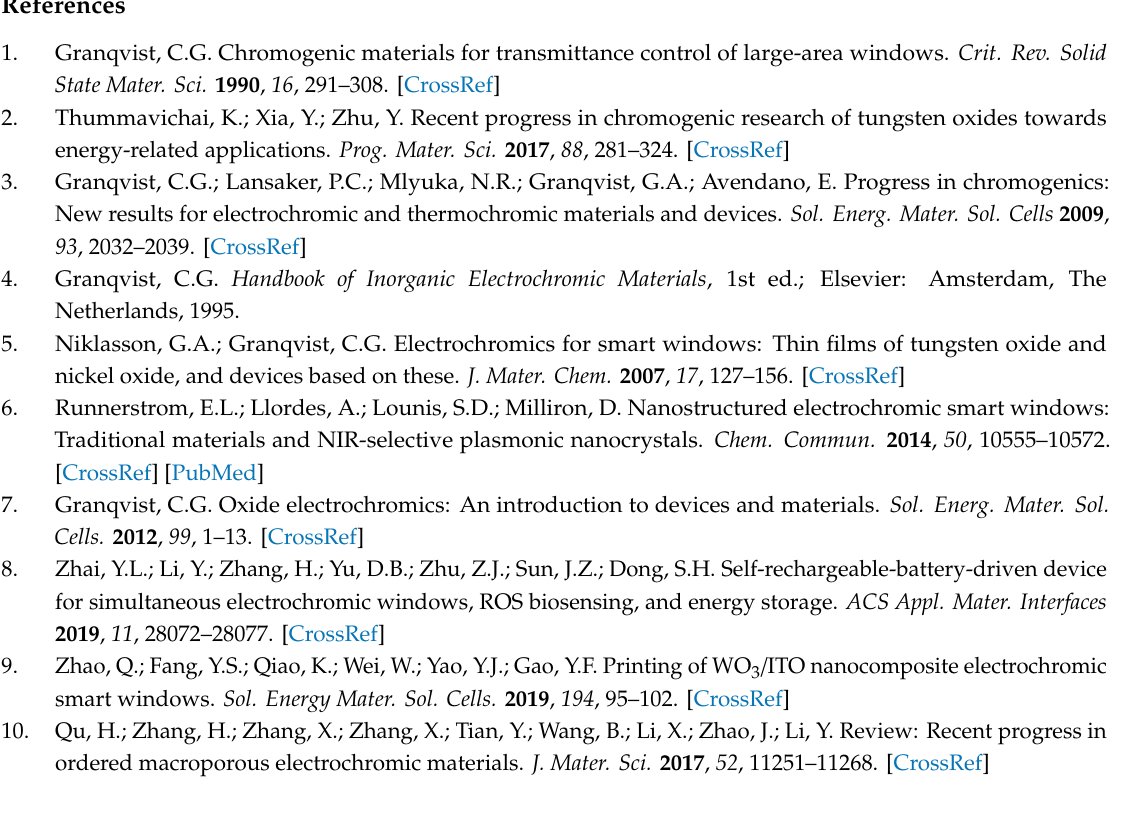
Figure S1: XRD of pristine TiO 2 and cerium modified films, Figure S2: Transmittance (%) vs wavelength for (a) plain glass, (b) FTO glass, (c) tungsten trioxide over FTO glass and (d) complete EC device, Figure S3: Transmittance(%) measured at 550nm vs number of cycles for the 9 cm × 10 cm